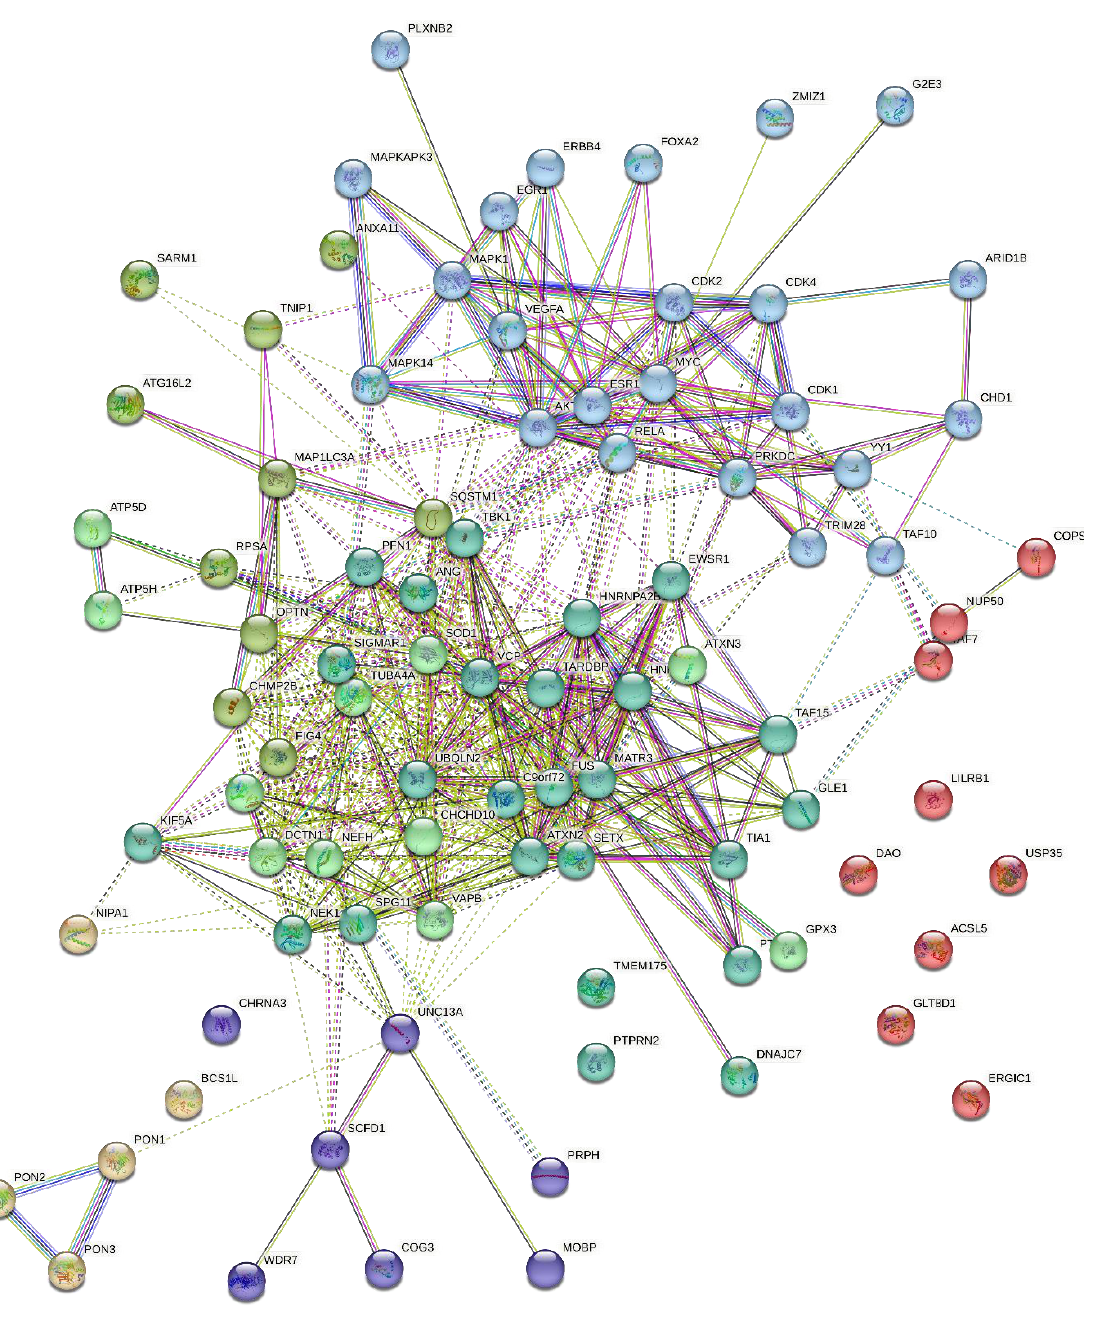
Figure 4. Protein-protein interaction network of all ALS-associated genes together with predicted kinases and transcription factors, visualized with k-mean clustering into seven clusters. Legend: Cluster 1: red (ACSL5, COPS7A, DAO, ERGIC1, GLT8D1, LILRB1, NUP50, TAF7, and USP35). Cluster 2: brown (BCS1L, NIPA1, PON1, PON2, and PON3). Cluster 3: olive (ANXA11, ATG16L2, CHMP2B, FIG4, MAP1LC3A, OPTN, RPSA, SARM1, SQSTM1, and TNIP1). Cluster 4: green (ALS2, ATP5D, ATP5H, ATXN3, CHCHD10, DCTN1, GPX3, NEFH, SOD1, TUBA4A, and VAPB). Cluster 5: blue (ANG, ATXN2, C9orf72, DNAJC7, EWSR1, FUS, GLE1, HNRNPA1, HNRNPA2B1, KIF5A, MATR3, NEK1, PFN1, PTBP2, PTPRN2, SETX, SIGMAR1, SPG11, TAF15, TARDBP, TBK1, TIA1, TMEM175, UBQLN2, and VCP). Cluster 6: light sky blue (AKT1, ARID1B, CDK1, CDK2, CDK4, CHD1, EGR1, ERBB4, ESR1, FOXA2, G2E3, MAPK1, MAPK14, MAPKAPK3, MYC, PLXNB2, PRKDC, RELA, TAF10, TRIM28, VEGFA, YY1, and ZMIZ1). Cluster 7: medium blue (CHRNA3, COG3, MOBP, PRPH, SCFD1, UNC13A, and WDR7). Dotted lines show inter-cluster interactions.